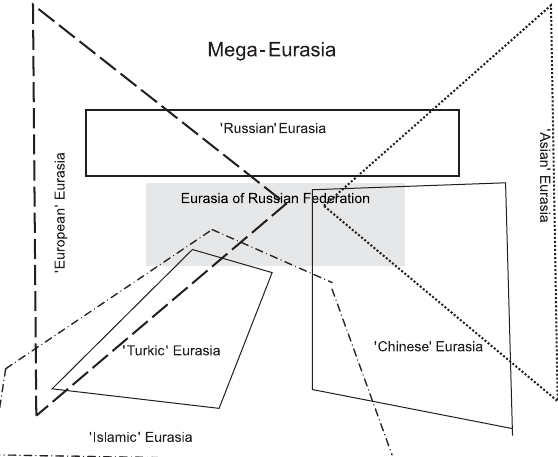
Fig. 2. Polycentric model of Mega-Eurasia: conceptual scheme.